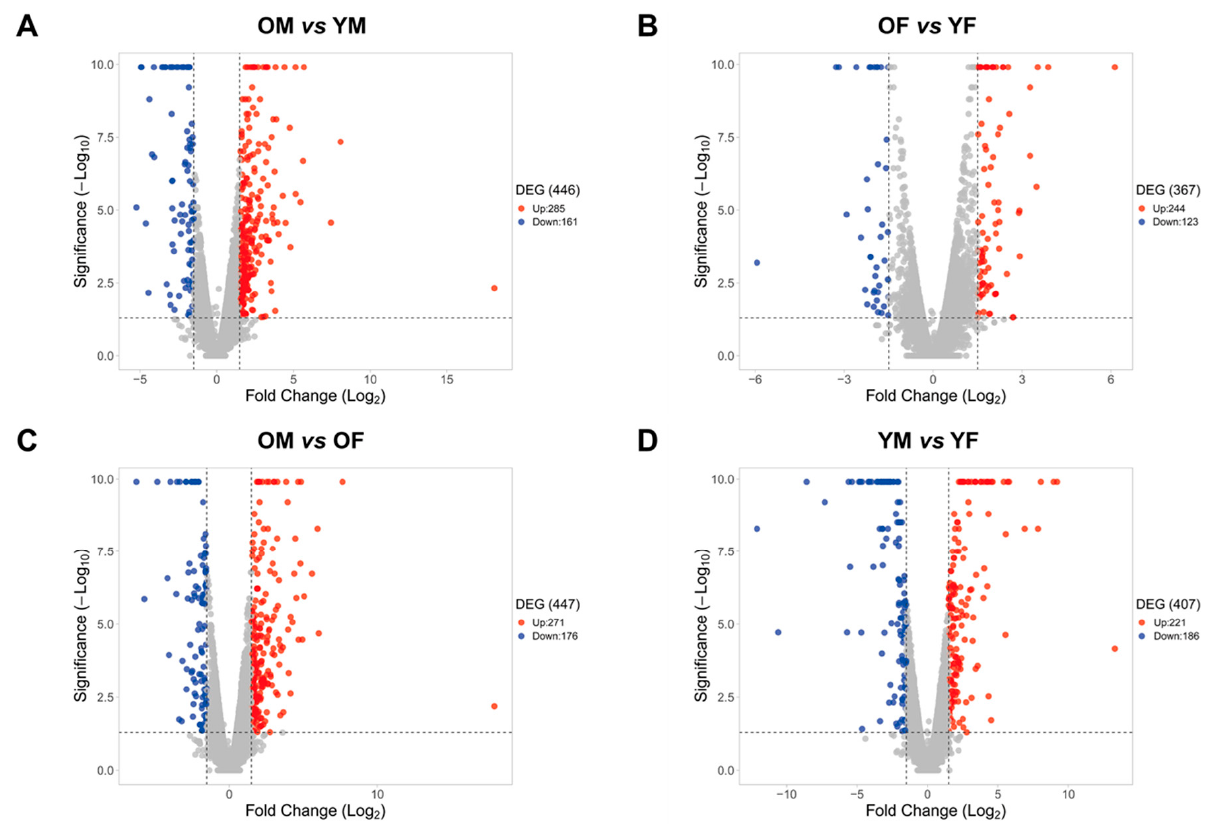
Figure 1. Study designs for transcriptomic analysis of age and sex differences. RNA-Seq data of rat liver tissues were categorized into four groups, and DEGs were calculated by two groups. OM, old male; YM, young male; OF, old female; YF, young female.